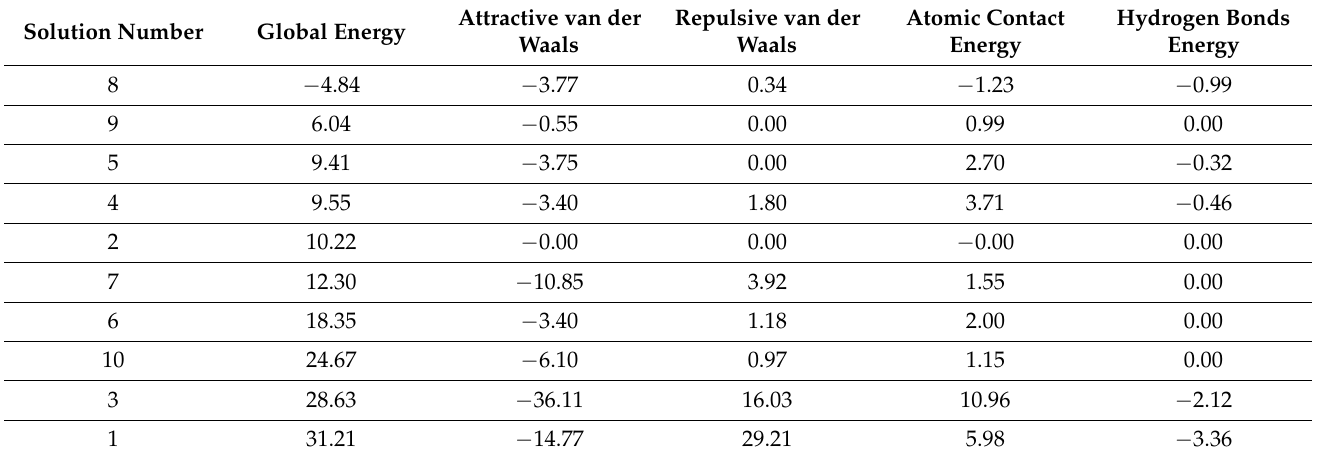
Table 11. Refined docked solution of the vaccine with MHC − I, generated by the FireDock webserver.